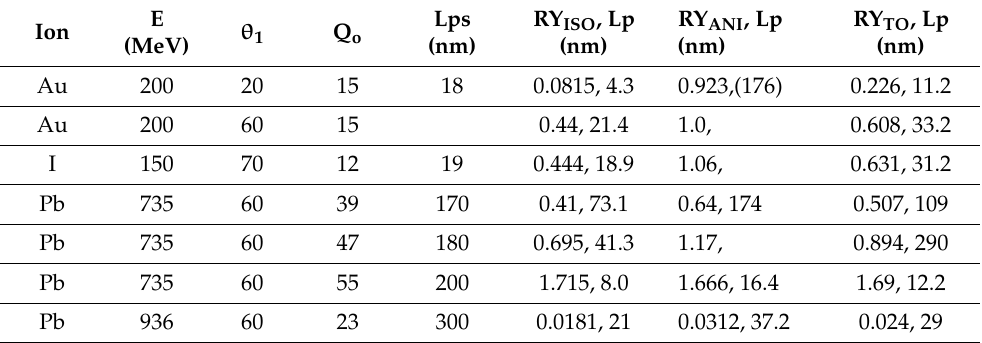
Table 9. A summary of LiF sputtering. Ion, energy (E in MeV), incident angle ( θ 1 ◦ ) measured from the surface normal, incident charge (Q o ), equilibration length (L ps , reaching 90% of the electronic stopping power at the equilibrium–charge) [36], ratio (RY) of the sputtering yield under the non-equilibrium charge (Q o ) incidence over that the equilibrium-charge (Q eq ) incidence for isotropic, anisotropic components and total. Lp is the length such that the calculated RY equals to the experimental